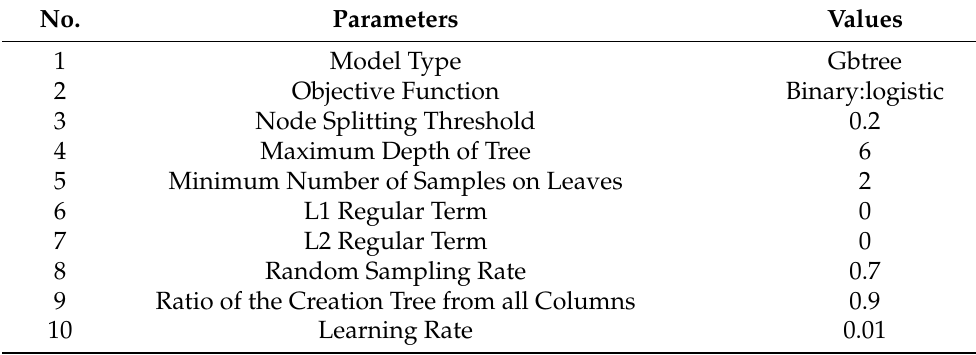
Table 11. Parameters for XGBoost.